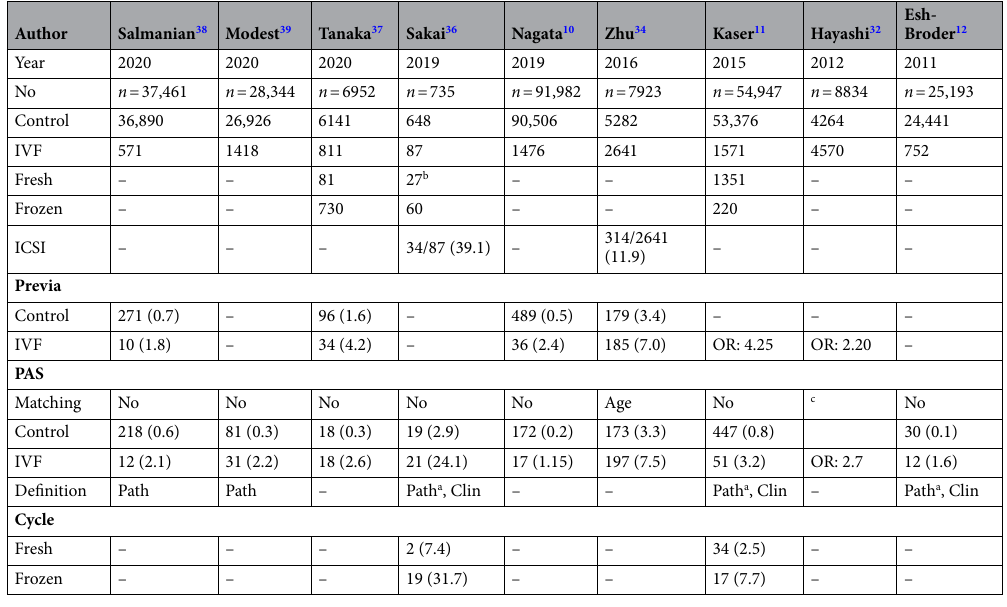
Table 3. Comparator analysis of PAS between women with IVF-ET and those with non-IVF-ET. The numbers (percentages per column) are shown. a Included cases without cesarean hysterectomy. b Two cases underwent FET during the ovulation cycle. c Controls matched for maternal age, parity, BMI, smoking, alcohol consumption, and pre-existing maternal diseases. Path histopathological diagnosis, clin clinical diagnosis, –, not applicable; definition definition of placenta accreta spectrum, matching patient background matching, previa placenta previa, OR odds ratio, PAS placenta accreta spectrum, IVF in vitro fertilization-embryo transfer, fresh fresh embryo transfer, frozen frozen embryo transfer, FET frozem embryo transfer, ICSI Intracytoplasmic sperm